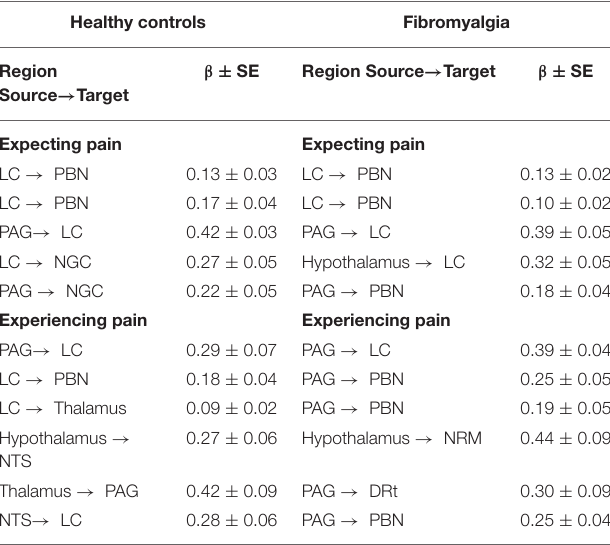
TABLE 3 | Pearson’s correlations of group questionnaire scores (FM or HC) with individual normalized pain score (calculated as mean pain intensity/mean stimulus temperature for each individual).